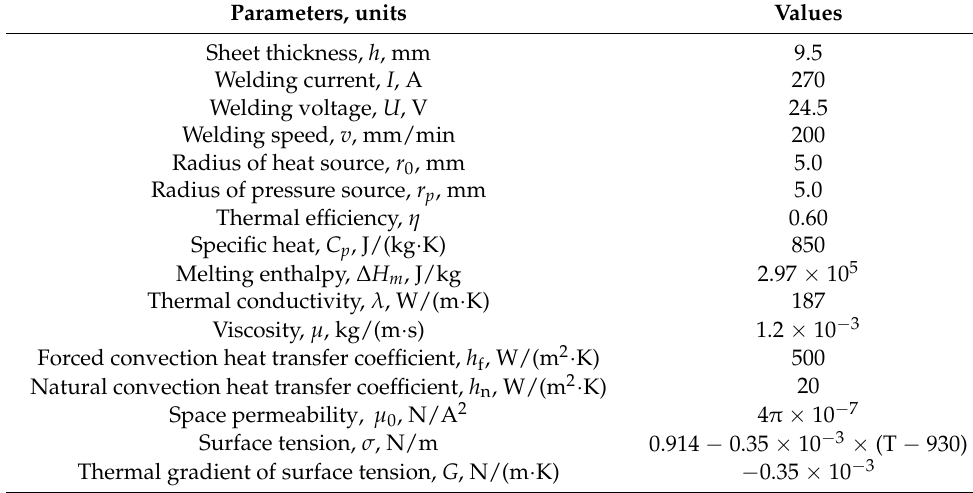
Table 2. Process and material properties parameters used in CFD numerical